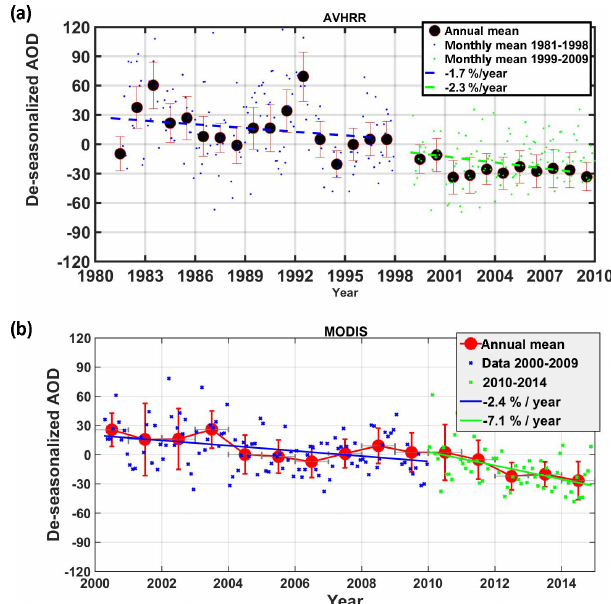
Figure 12. (a) Variability of de-seasonalized monthly AVHRR- based AOD 630nm from 1981 to 2009 (black), along with linear trends for the periods 1981–1997 (blue) and 1998–2009 (green). Vertical bars describe the standard deviation of the annual value based on the monthly ones (upper graph). (b) Variability of MODIS- based de-seasonalized monthly AOD 550nm from 2000 to 2014 (red), along with linear trends for the periods 2000–2009 (blue) and 2010–2014 (green). Vertical bars describe the standard deviation of the annual value based on the monthly ones and grey horizontal bars the respective year (lower graph).